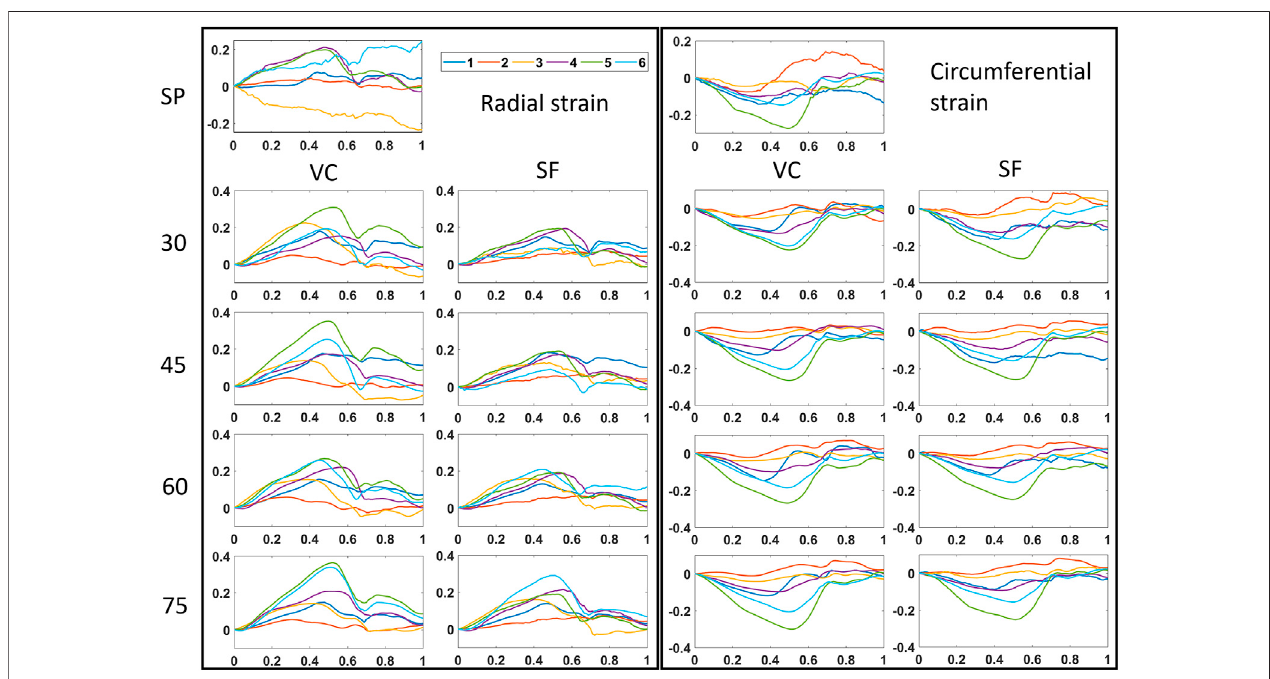
FIGURE 8 | Time strain curves for all multi-perspective datasets (30 ° – 75 ° ). Both radial and circumferential strain curves are shown for single-perspective imaging (SP), and multi-perspective, unit axial vectors based compounding (VC) and strain fusion (SF), respectively.